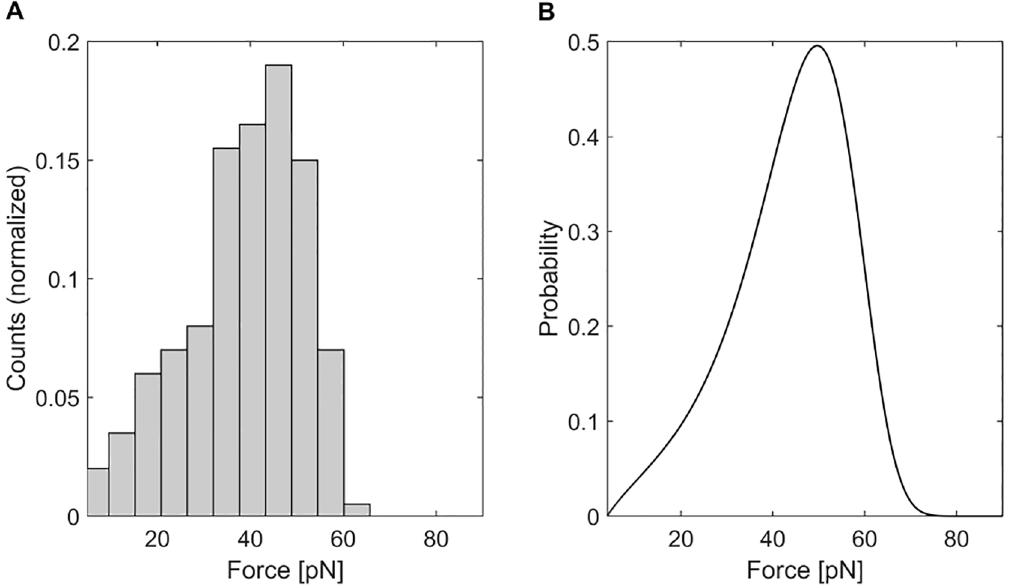
Fig 5. Forces at the first unfolding event. A Histogram of forces at the first unfolding event (bin size based on the Freedman-Diaconis rule [44]) of 200 Monte Carlo simulation reveal a deviation (in terms of most likely unfolding forces) from the corresponding exact probability B .